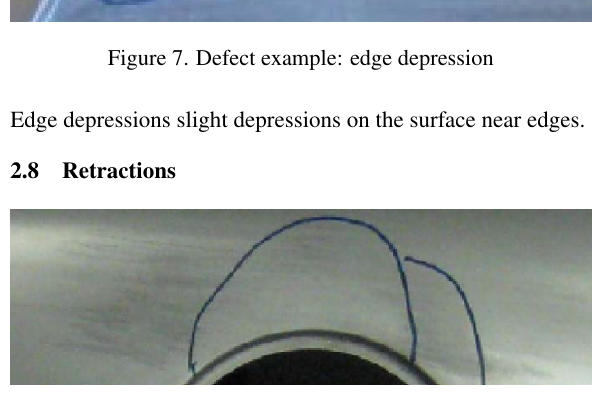
Figure 8. Defect example: retraction Retractions are slight, flat depressions on the surface. 2.9 Slip Lines Slip lines are visible lines on the surface caused by bend- ing components around tight radii. They occur at the border between material which has been stretched over a radius and material which has not. No image